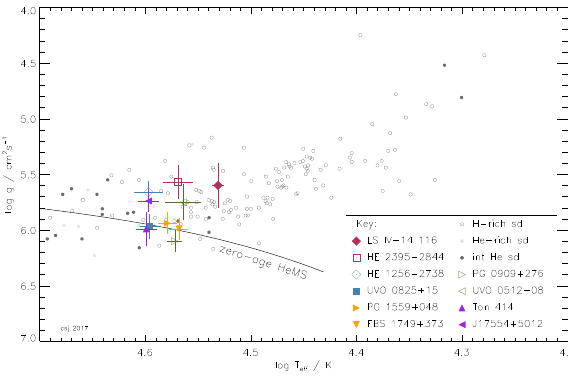
Figure 4. Surface properties of super metal-rich hot subdwarfs, including the pulsating stars LS IV−14 ∘ 116 and UVO 0825+15, the iron-group CP stars UVO0512–08 and PG0909+276 (Wild & Jeffery: sdOB8), and the new lead-rich discoveries.